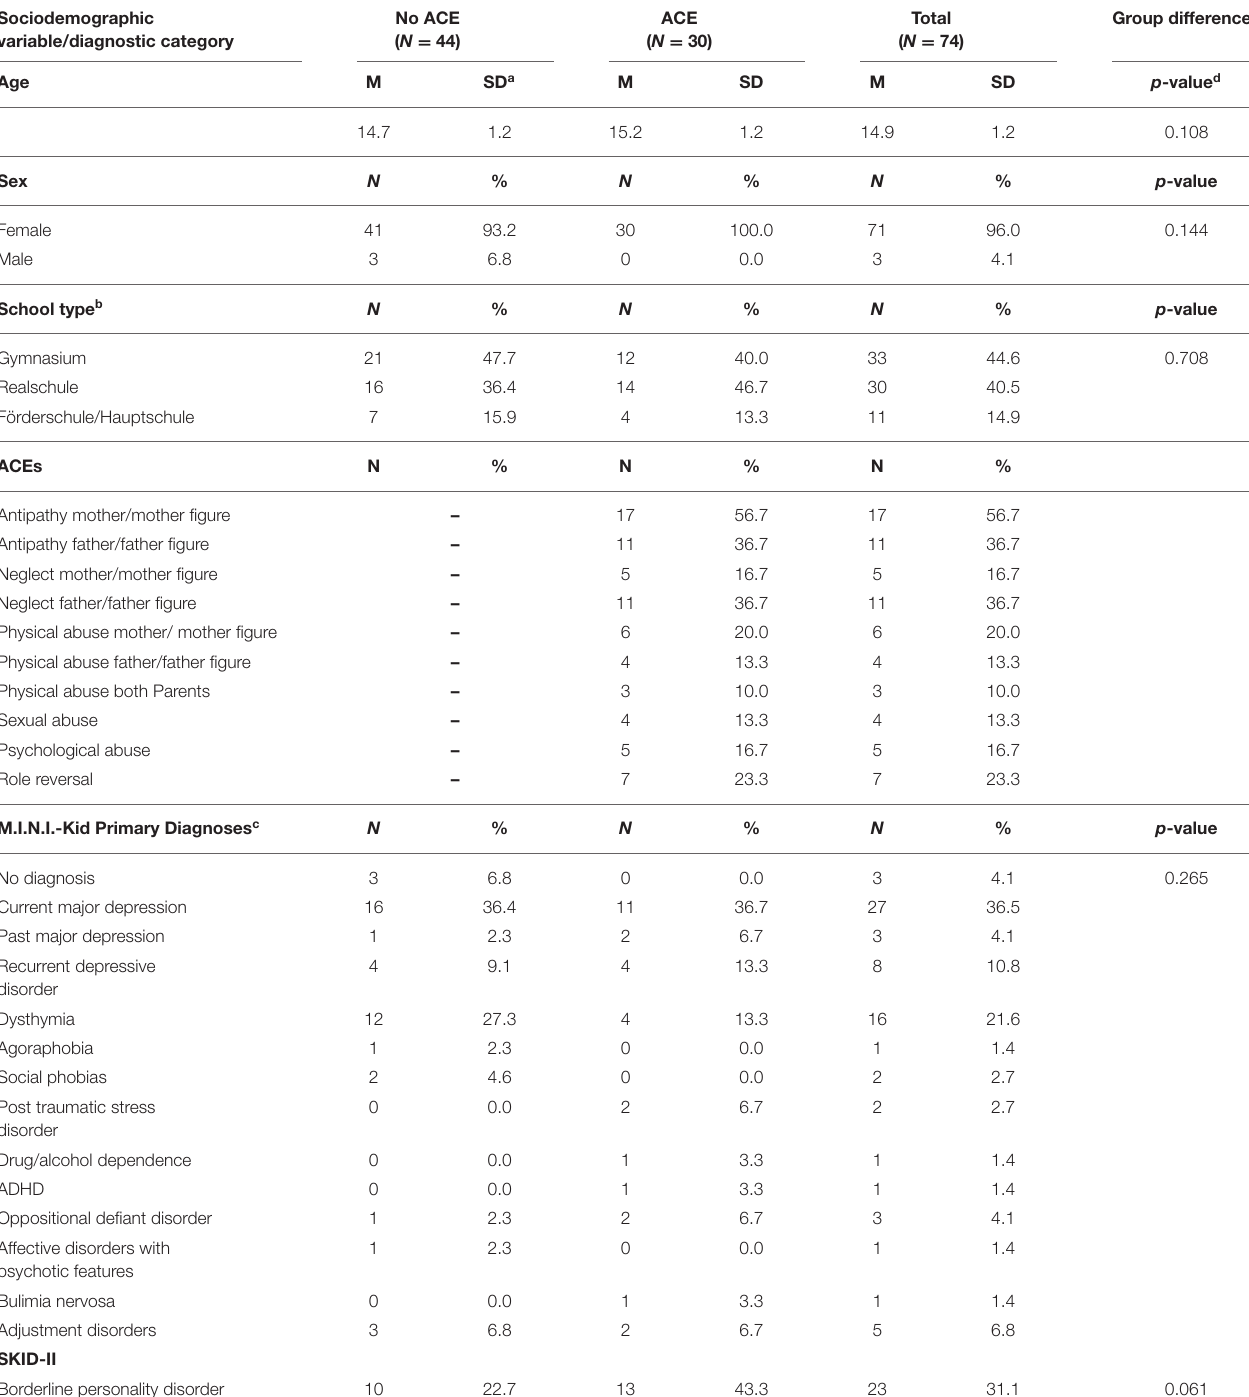
TABLE 1 | Sociodemographic and clinical characteristics of participants by ACEs at T0. Sociodemographic variable/diagnostic